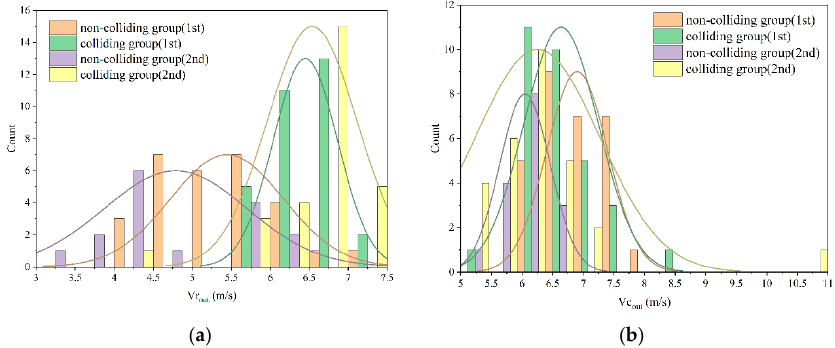
Figure 14. The radial and circumferential velocities of the particles: ( a ) distribution of radial velocity Vr out ; ( b ) distribution of radial velocity Vc out .